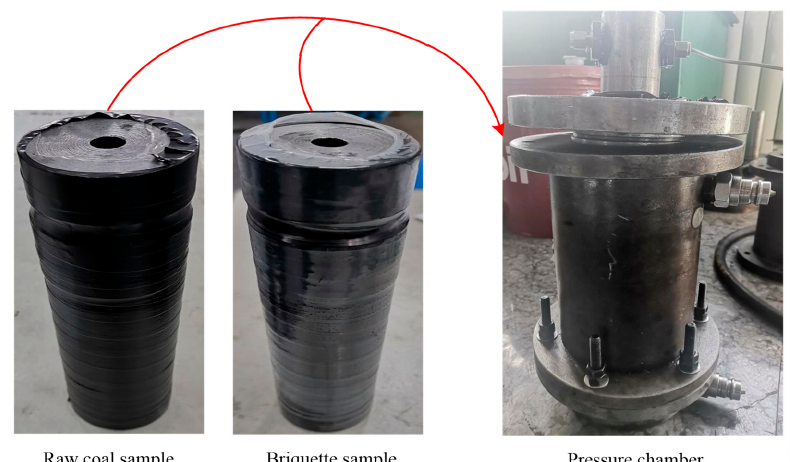
Figure 4. Sealed